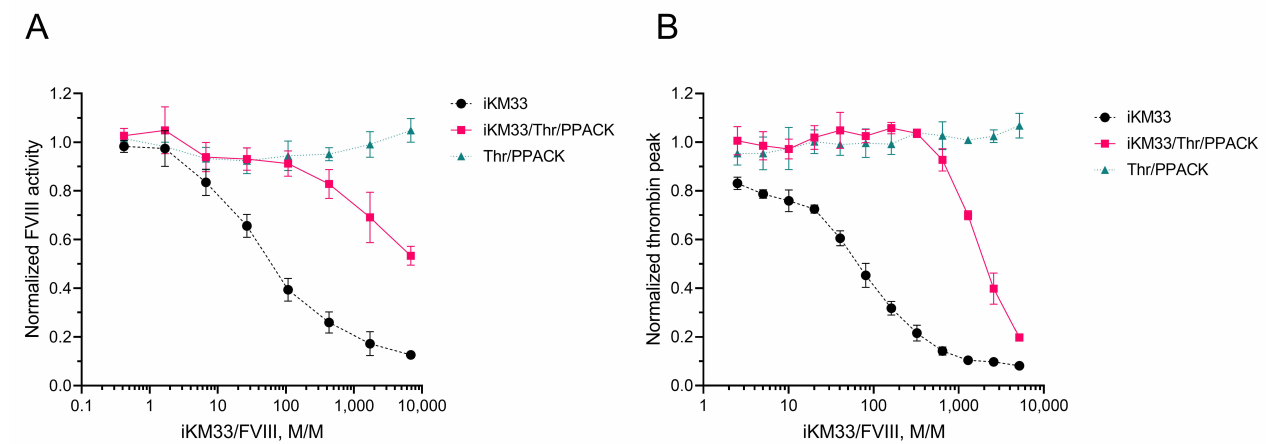
Figure 6. Effect of thrombin-cleaved iKM33-v2 on FVIII activity. ( A ) Three samples were pre- pared as (i) scFv, (ii) scFv treated with thrombin followed by termination of reaction by PPACK (scFv/Thromb/PPACK), and (iii) buffer treated with thrombin followed by addition of PPACK (con- trol) (Thrombin/PPACK). Serially diluted samples (iKM33 concentration from 1000 to 0.24 nM) were incubated with FVIII (145 pM) and tested by CS assay. The results were normalized to FVIII incubated with thrombin-treated buffer. Mean ± SD, n = 4. ( B ) The samples were prepared similarly to panel A, but thrombin was removed from the reactions using biotinylated PPACK followed by incubation with streptavidin beads. Serially diluted samples (iKM33 concentration from 600 to 0.3 nM) were incubated with FVIII (116 pM) for 15 min and tested by TG assay. The results were normalized to FVIII incubated with Tris-BSA buffer (pH 7.2). Mean ± SD, n =